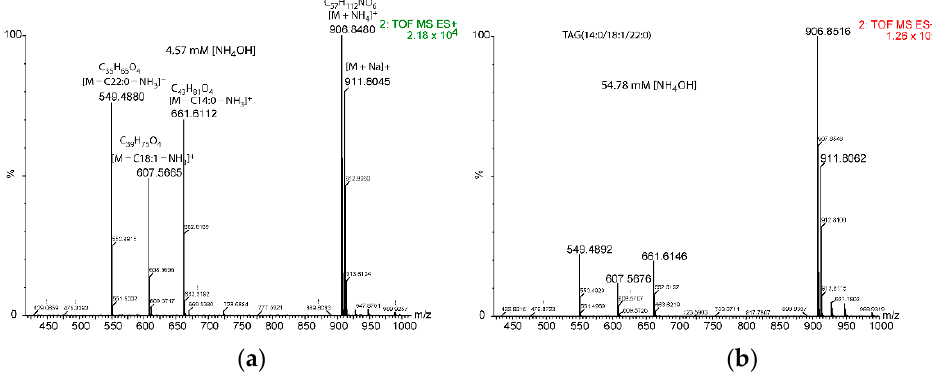
Figure 5. Comparative fragmentation intensity under two ammonium concentrations for TAG(14:0/18:1/22:0). Adducts and elemental compositions are only shown in panel ( a ) for the sake of clarity. Relative intensity of the [M + NH 4 ] + adduct was 2.18 × 10 4 for 4.57 mM [NH 4 OH] (panel ( a )) and 1.26 × 10 5 for 54.78 mM [NH 4 OH] (panel ( b )).